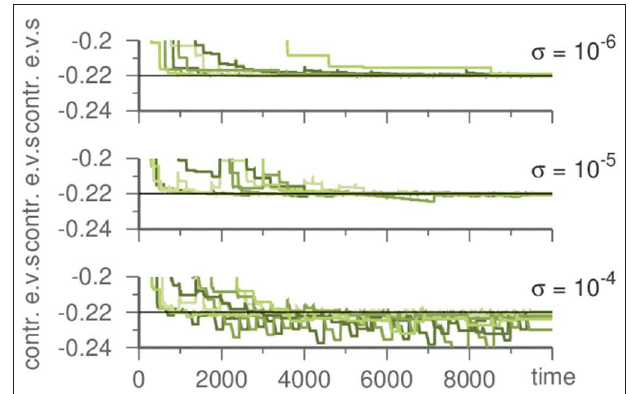
FIGURE 3 | Learning all eigenvalues of a Kirk-Silber network. Eigenvalues are grouped by their corresponding direction. Horizontal dotted lines mark the true values. Transverse eigenvalues converge slightly slower, radial significantly. Parameters are ϑ 5, γ 1, ρ 10, and σ 10 − 6 . = = = =